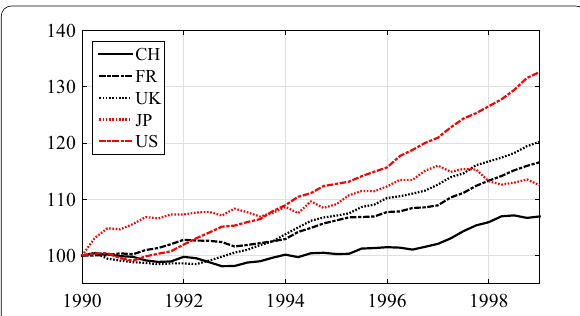
Fig. 1 Real GDP (1990Q1